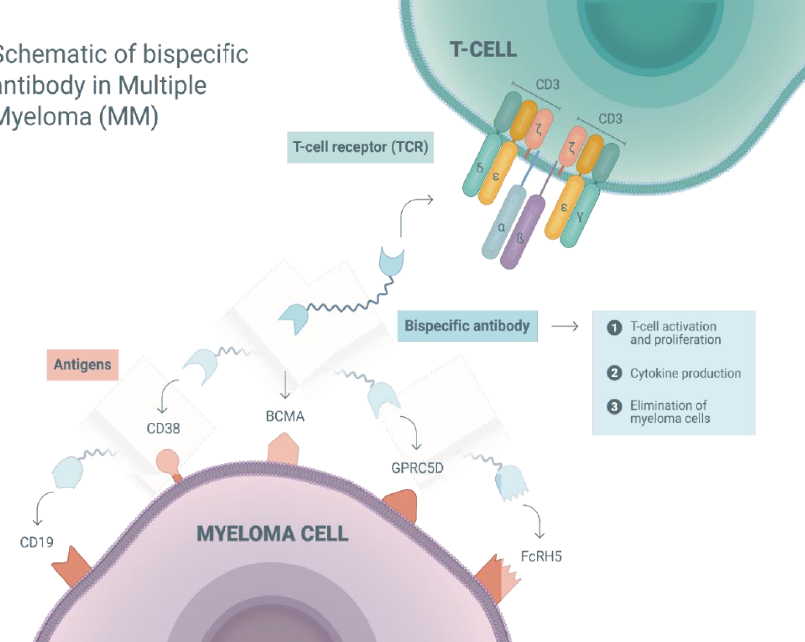
Figure 1. Schematic of a bispecific antibody in multiple myeloma (MM): mechanisms of action and potential targets. Bispecific antibodies facilitate an immune synapse between T-cell and myeloma